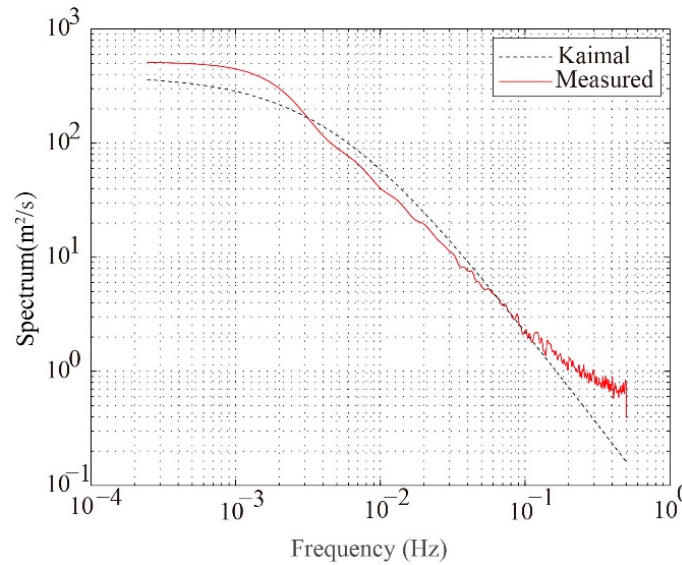
Figure 3. Wind velocity spectrum and Kaimal spectrum.